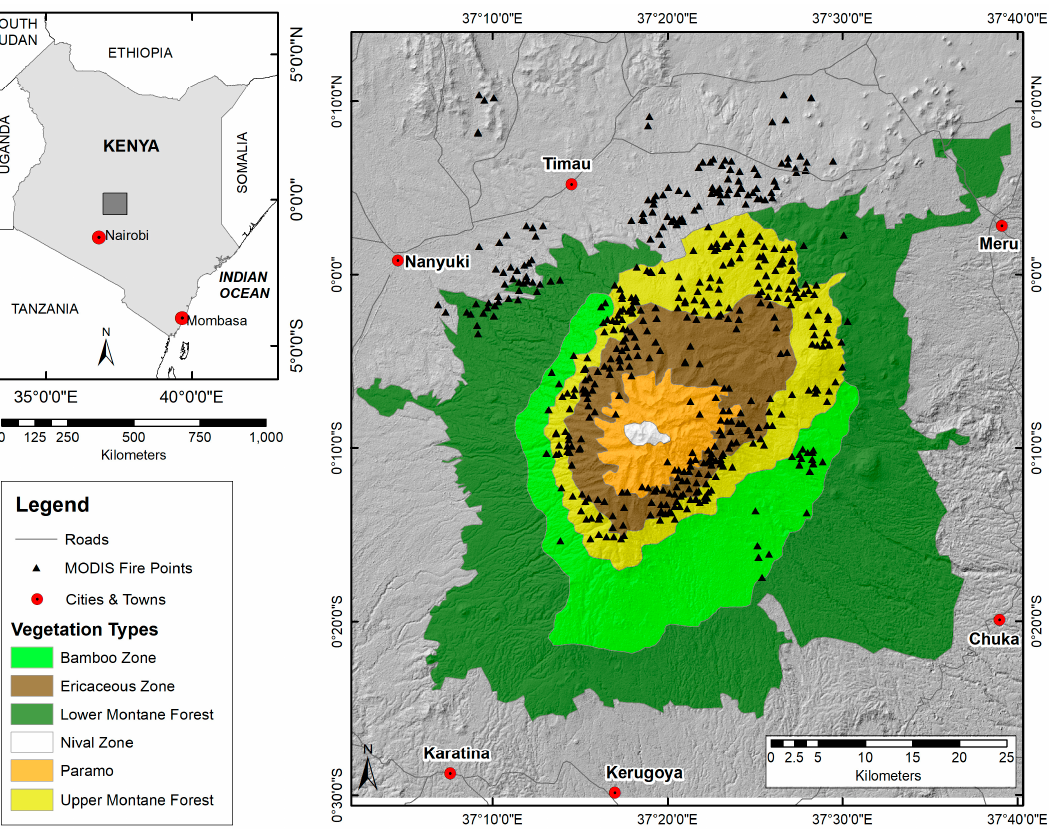
Figure 1. Location of study in Central Kenya with vegetation zones and MODIS active fire detection points shown (2004–2015). Gray rectangle on locator map shows location of Mount Kenya and inset map. All towns and cities (in red) are labeled with names, MODIS data are shown as black triangles with no labels.